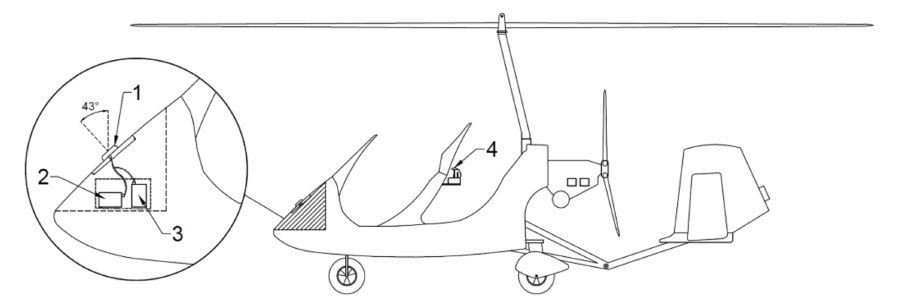
Figure 3. Antenna setup on board of the aircraft. (1) Right-hand circular polarized GNSS antenna, (2) receiver for reflectometry, (3) receiver for navigation, and (4) Extra GPS+INS Drone flight